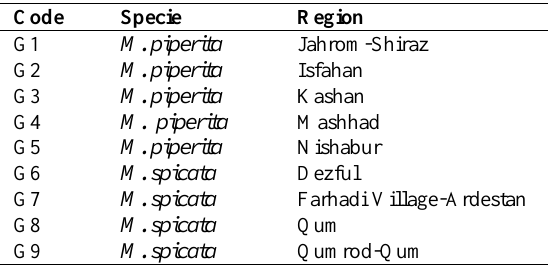
Table 1. Species of the genus Mentha collected from different